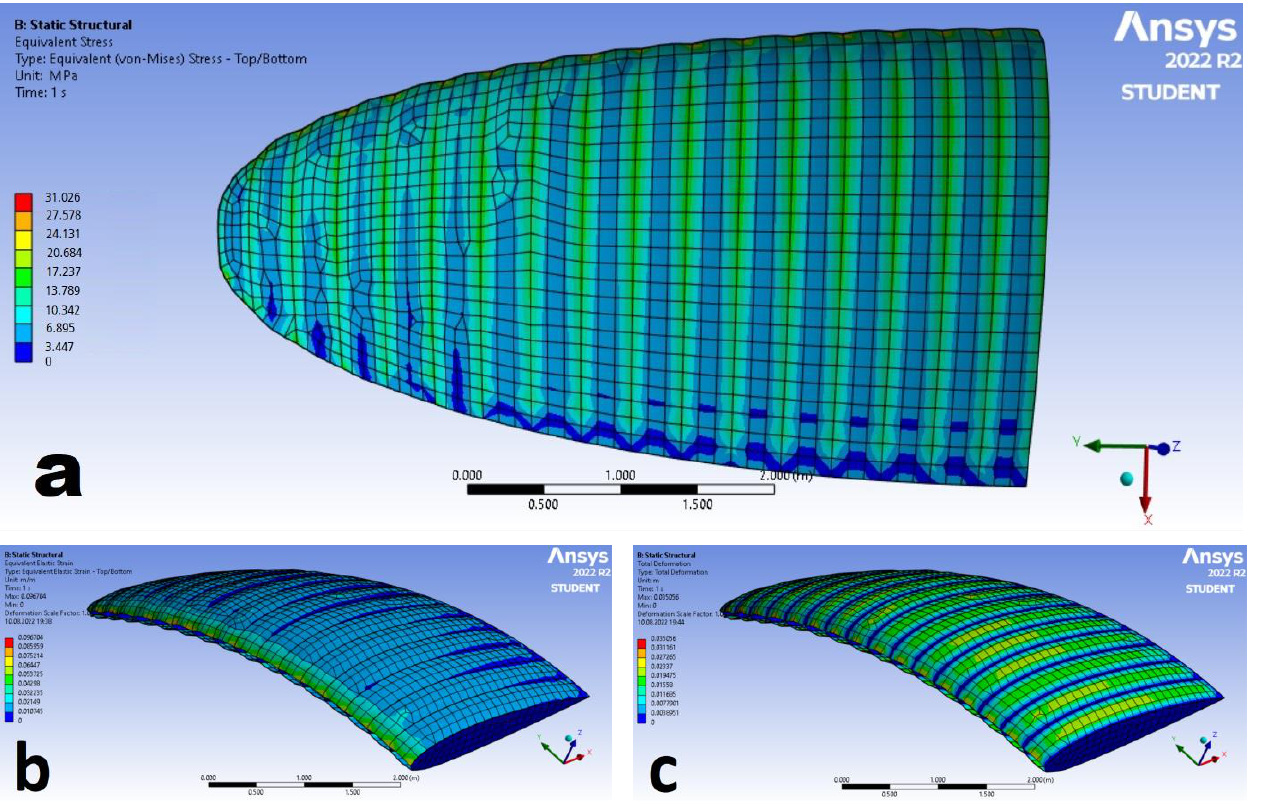
Table 7. The biggest representative (repetitive) values of stress, strain, and deformation based on the visual results; averaged.